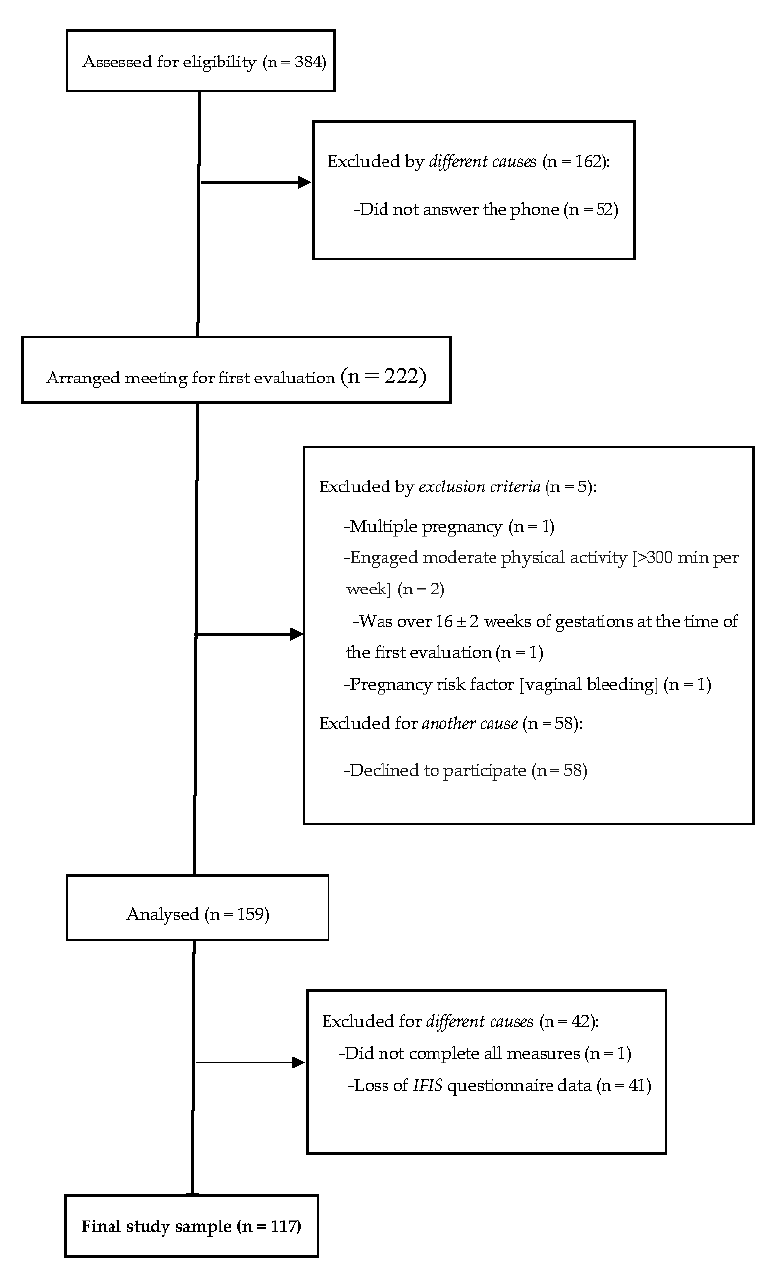
Figure 1. Flow diagram of study participants.